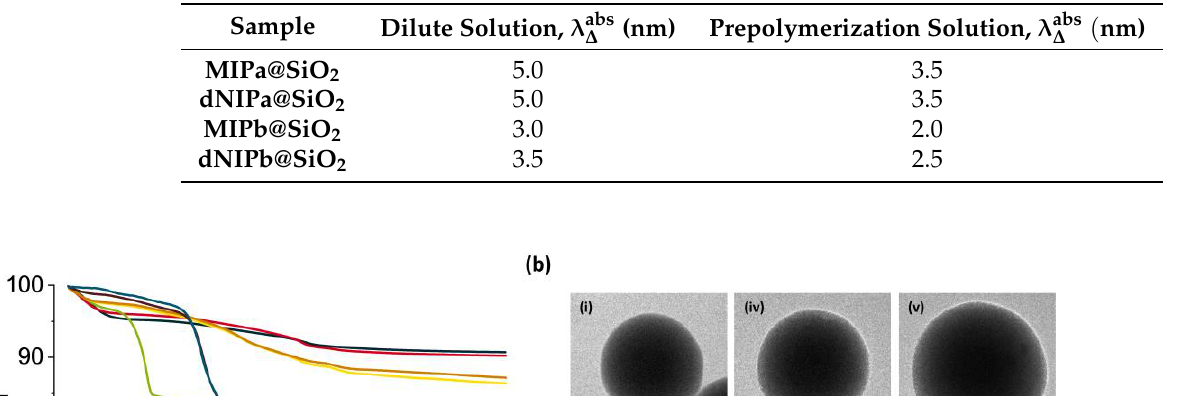
Table 1. Bathochromic shifts in absorption maxima ( λ abs ∆ ) after the addition of the templates in dilute solution and the pre-polymerization mixtures for MIPa@SiO 2 , dNIPa@SiO 2 , MIPb@SiO 2 and dNIPb@SiO 2 in the corresponding solvents. Equimolar amounts of I and the template were used.